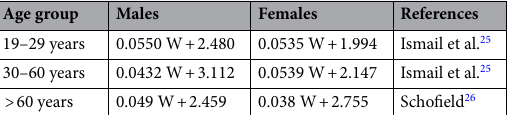
Table 3. Basal metabolic rate (BMR) equations. BMR is expressed in MJ/day, W = body weight in